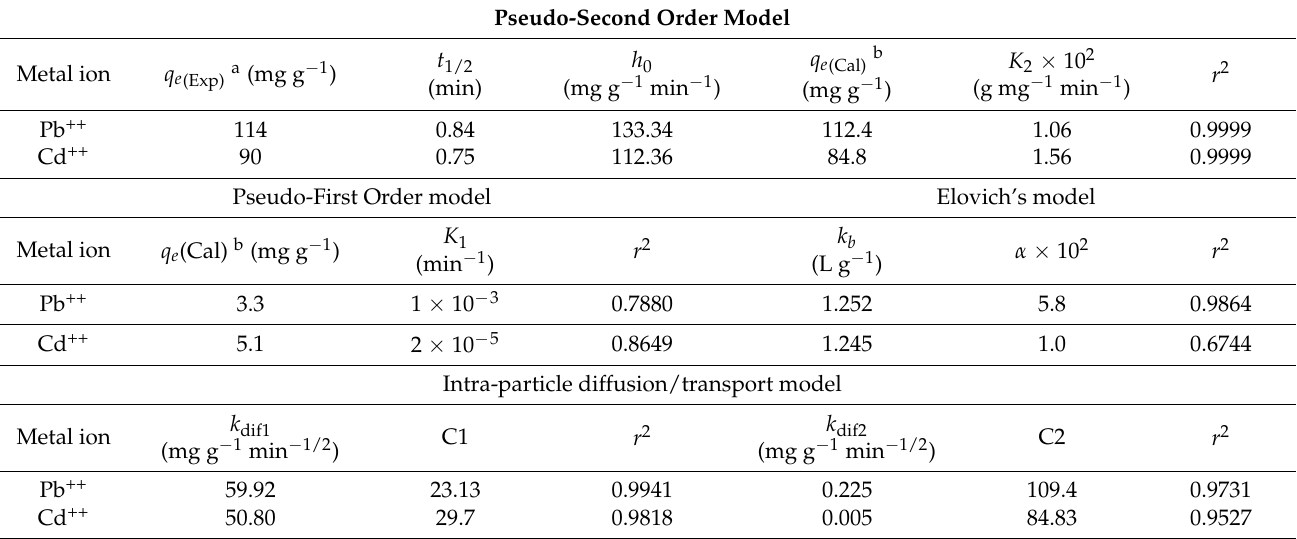
adsorption kinetics of Pb ++ /Cd ++ ions from water by MGCN nanocomposite, as shown in Figure 7b–d. The models’ kinetic linear equations are listed in Table 1 while the obtained parameters are given in Table 2. The fit of the experimental data with the theoretical mod- els is validated by expressing the correlation coefficient r 2 , i.e., the higher r 2 value, the more suitable the model for Pb ++ /Cd ++ uptake onto MGCN sorbent. Table 2. Kinetic models parameters for the adsorption of Pb and Cd by MGCN sorbent. Table 1. Kinetics models for the adsorption of Pb ++ /Cd ++ by MGCN sorbent. Pseudo-Second Order Kinetics Model